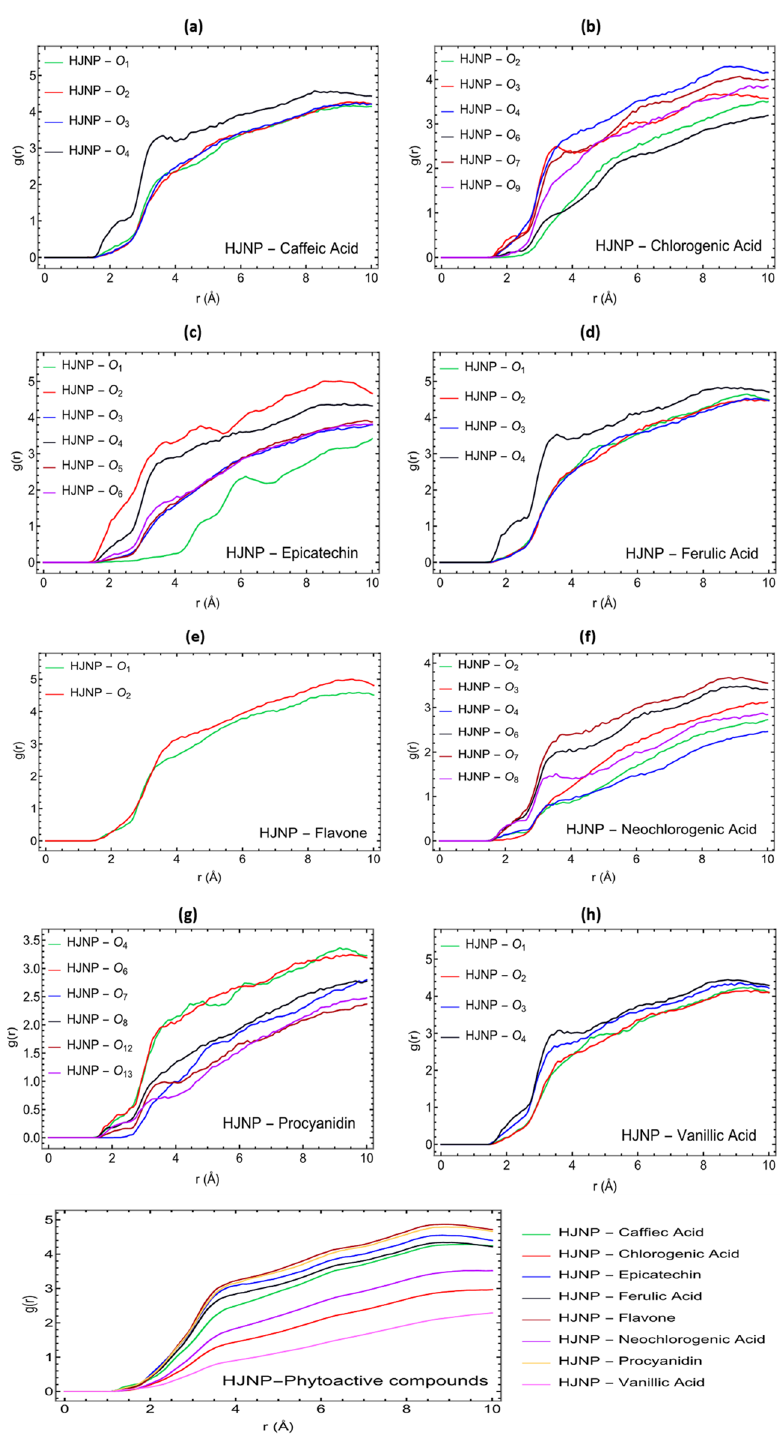
Figure 10. RDF plots for the active sites of ( a ) Caffeic acid, ( b ) Chlorogenic acid, ( c ) Epicatechin, ( d ) Ferulic acid, ( e ) Flavone, ( f ) Neochlorogenic acid, ( g ) Procyanidin, and ( h ) Vanillic acid with respect to the surface of hydronium jarosite nanoparticles. RDF plots of eight phytoactive compounds with respect to the surface of hydronium jarosite nanoparticles ( i